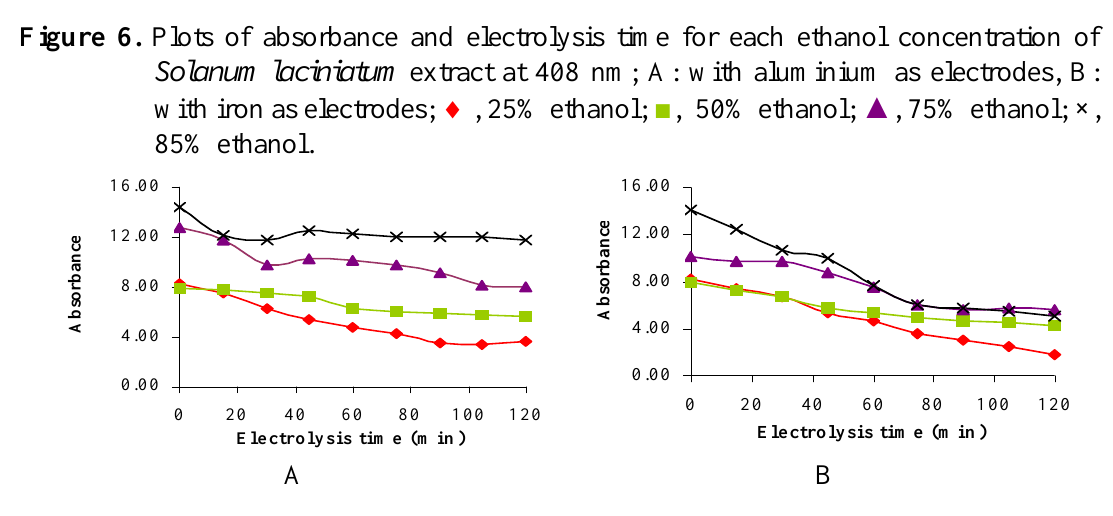
Figure 7. Plots of absorbance and electrolysis time for each ethanol concentration of Solanum laciniatum extract at 666 nm; A: with aluminium as electrodes, B: with iron as electrodes; ♦ , 25% ethanol; ■ , 50% ethanol; ▲ , 75% ethanol;